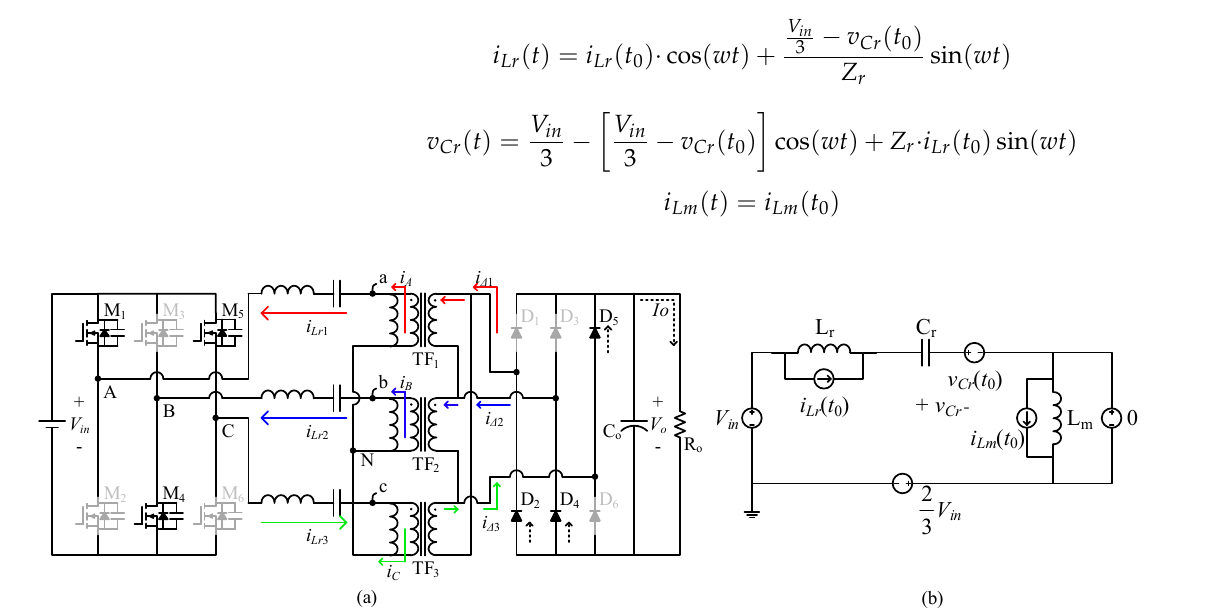
Figure 4. ( a ) Circuit station at Stage 1 ( b ) Equivalent circuit at Stage 1.